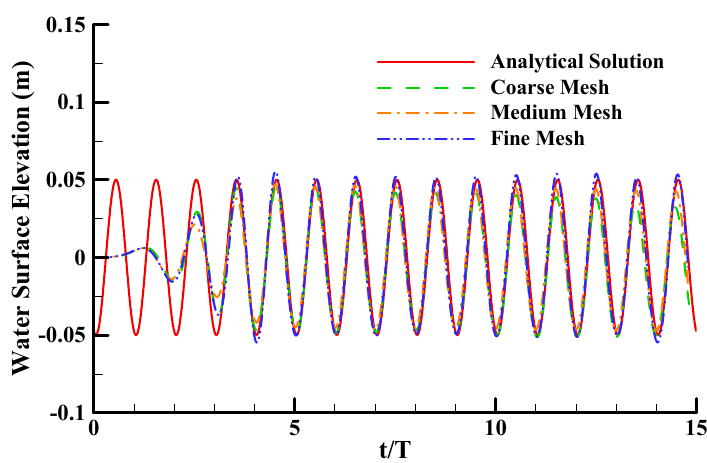
Figure 5. Time histories of water surface elevation at a fixed point with different mesh numbers. Table 1. Mesh number and corresponding computing time costs.